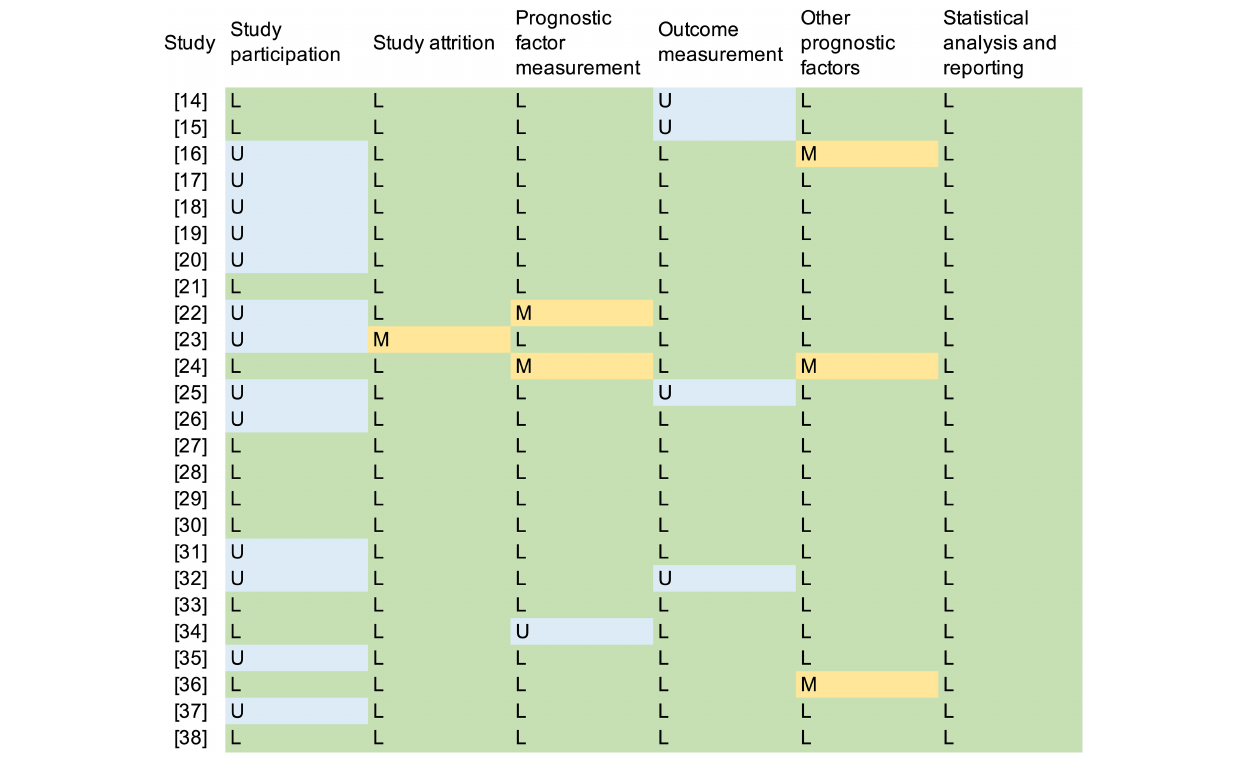
FIGURE 2 | Quality assessment according to the QUIPS. L , low risk; M , moderate risk; H , high risk; U ,